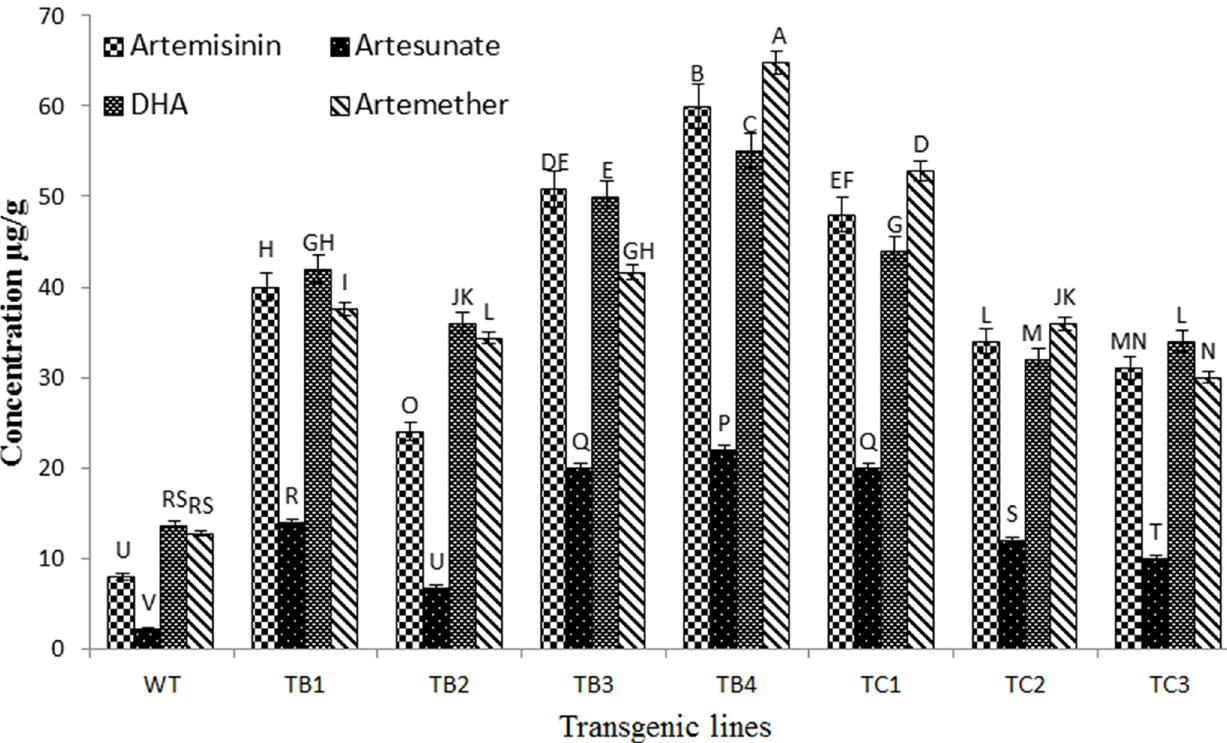
Fig 8. Quantitative analysis of artemisinin and derivatives. Comparative analysis of artemisinin content and its derivatives in wild type A . carvifolia and transgenics of rol B and rol C gene. Values with same alphabet did not differ significantly at 5% probability level using LSD. Error bars indicate the standard deviation.